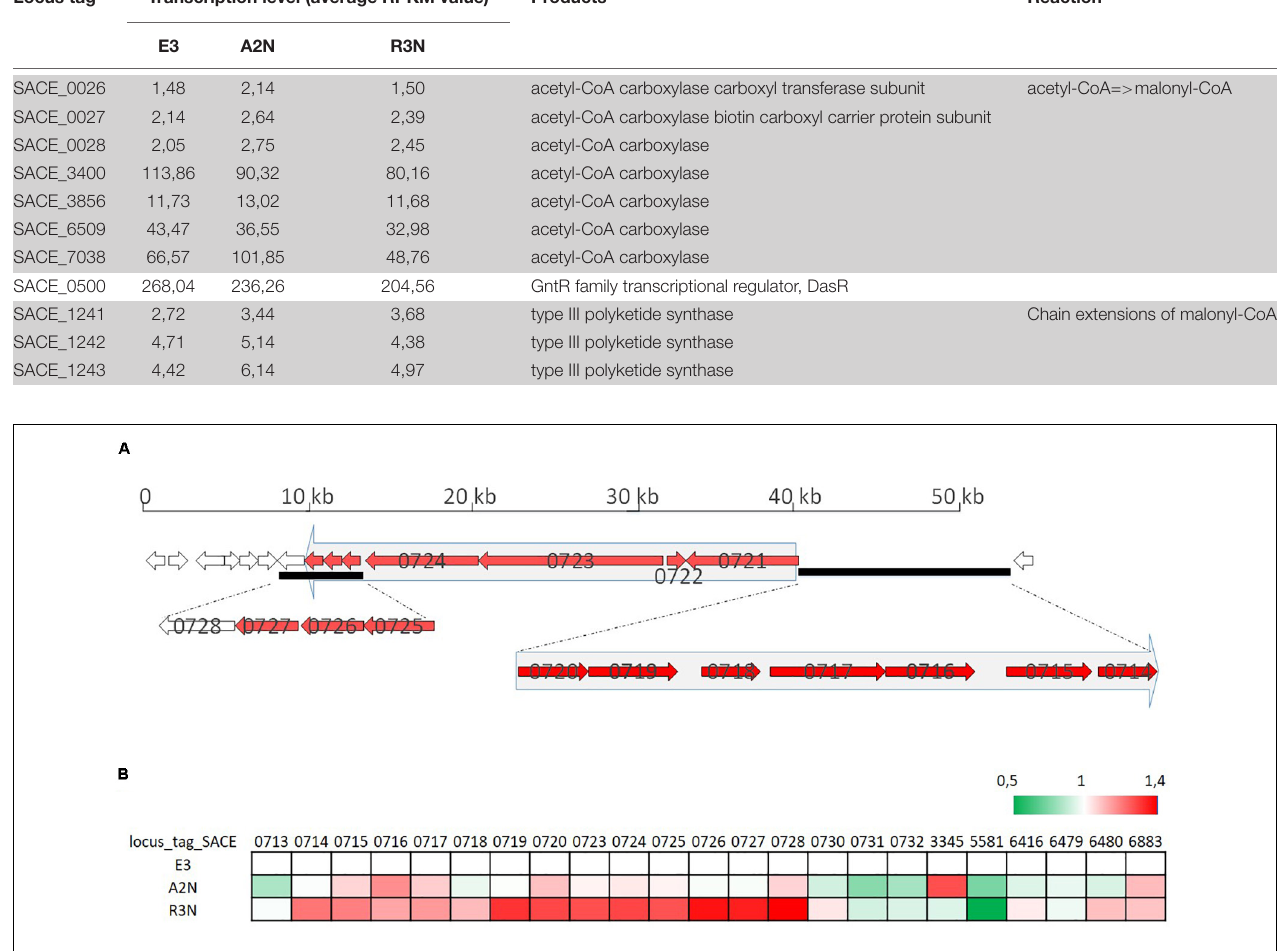
TABLE 3 | Transcription level of genes involved in the biosynthesis of pigment (7-O-rahmnosyl flaviolin). Locus tag